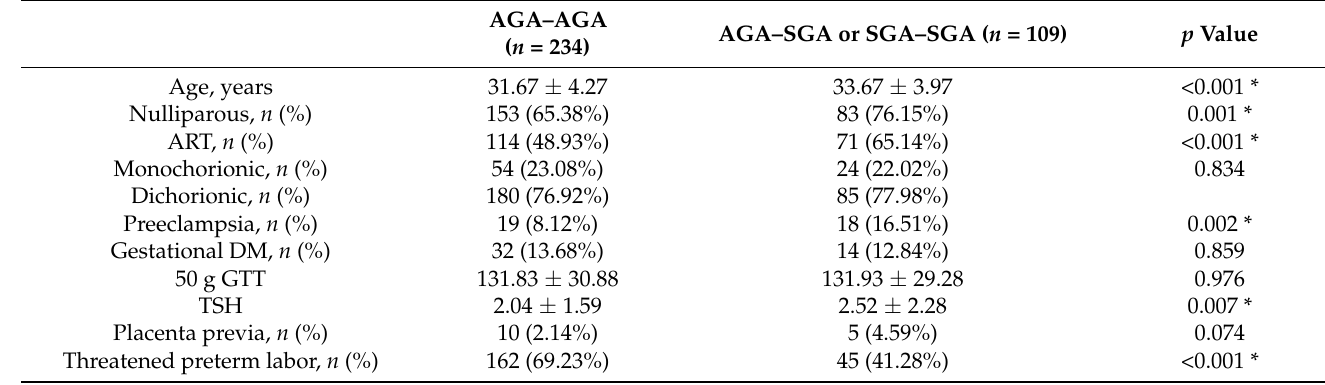
Table 3. Comparisons on obstetrical complications, neonatal prognosis, and maternal weight gain between the AGA–AGA group and AGA–SGA or SGA–SGA group, regardless of BMI using maternal pre-pregnancy weight in twin